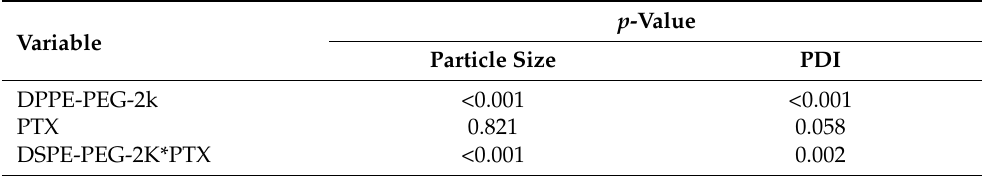
Table 7. ANOVA table for the effect of the DSPE-PEG-2k and drug on the particle size and PDI of NLC formulations.